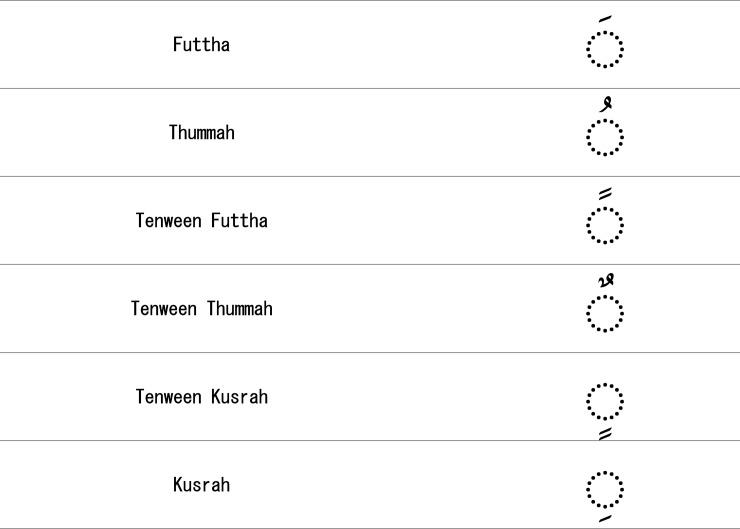
Main Arabic diacritics [18].